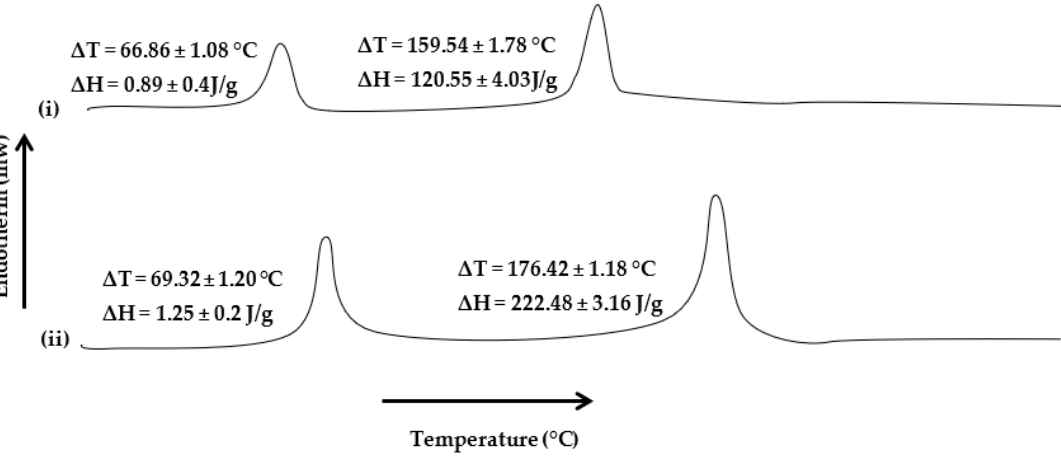
Figure 9. DSC thermograms of rat’s skin without (i) and (ii) with polymeric film treatment.